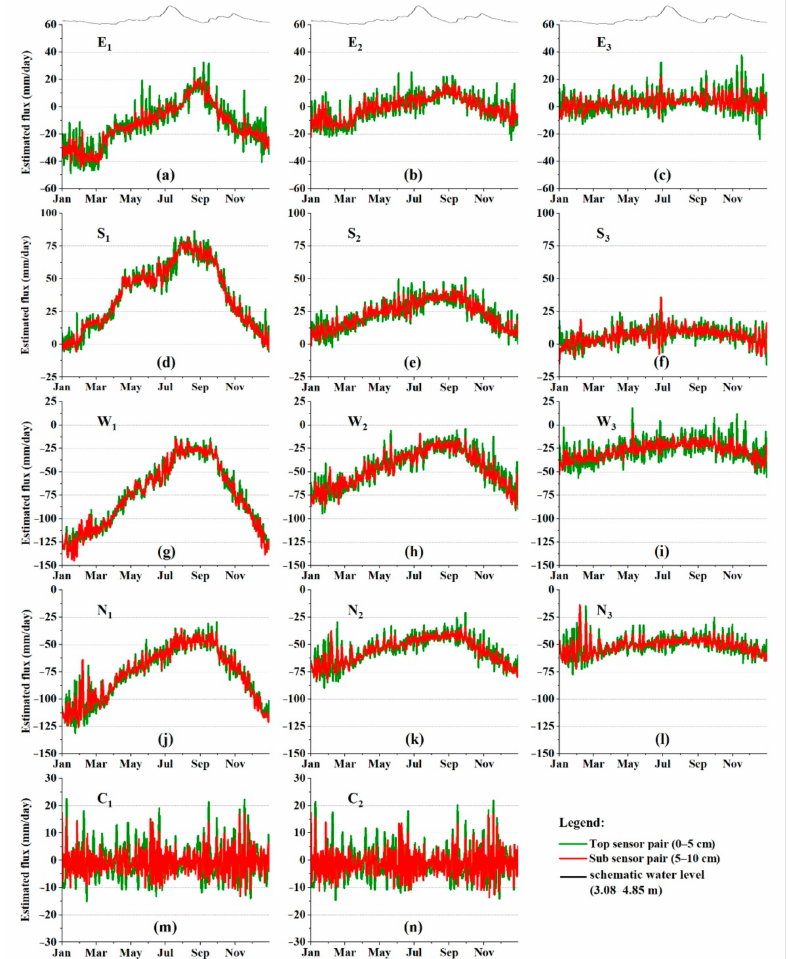
Figure 7. Estimated hyporheic flux over time at 14 sampling sites during 2016 using the VFLUX 2 model based on top (depths of 0 and 5 cm, green lines) and sub-top (depths of 5 and 10 cm, red lines) sensor pairs. Positive flux values represent downward flow and negative values represent upward flow. Site locations see Figure 1c. Schematic mean water level of Lake Taihu (3.08–4.85 m) was shown at the top of this figure (gray solid line).